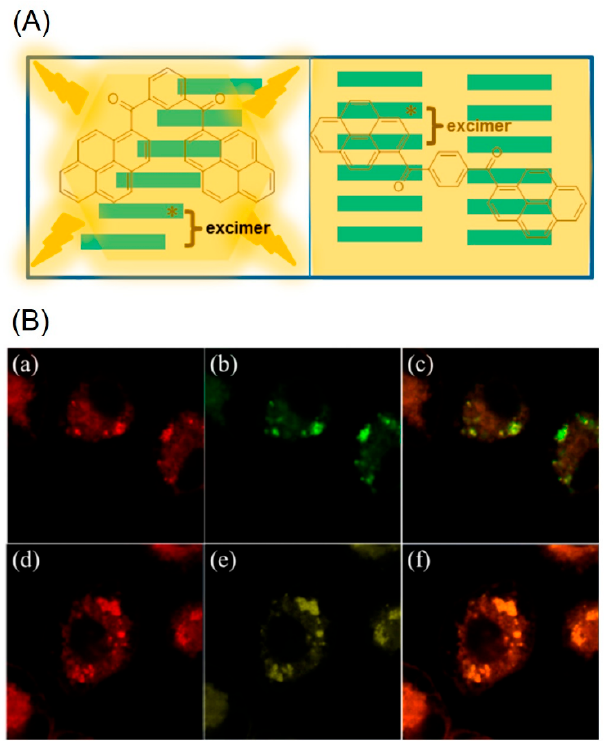
Figure 2. ( A ) Schematic representation of excimer formation by BP1 and BP2. ( B ) Colocalization of LysoTracker red and nanoaggregates. KB cells are double labeled with LysoTracker red ( a , d ) and nanoaggregates (( b ) stands for BP1 and ( e ) stands for BP2 ). The overlayed images are presented in ( c ) (overlayed image of ( a , b )) and ( f ) (overlayed image of ( d , e )). Excitation wavelength: 577 nm (for LysoTracker red) and 350 nm (for BP1 and BP2 ) (Reproduced with the permission from Ref.